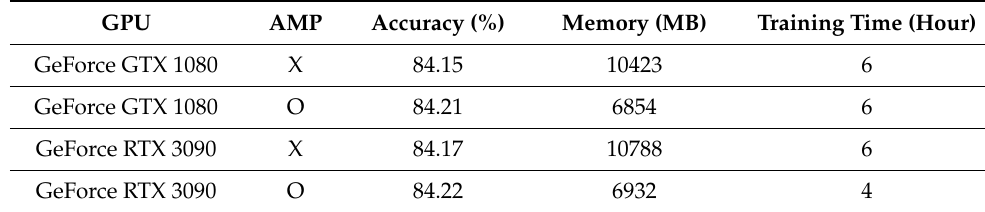
Table 5. AMP performance comparison.